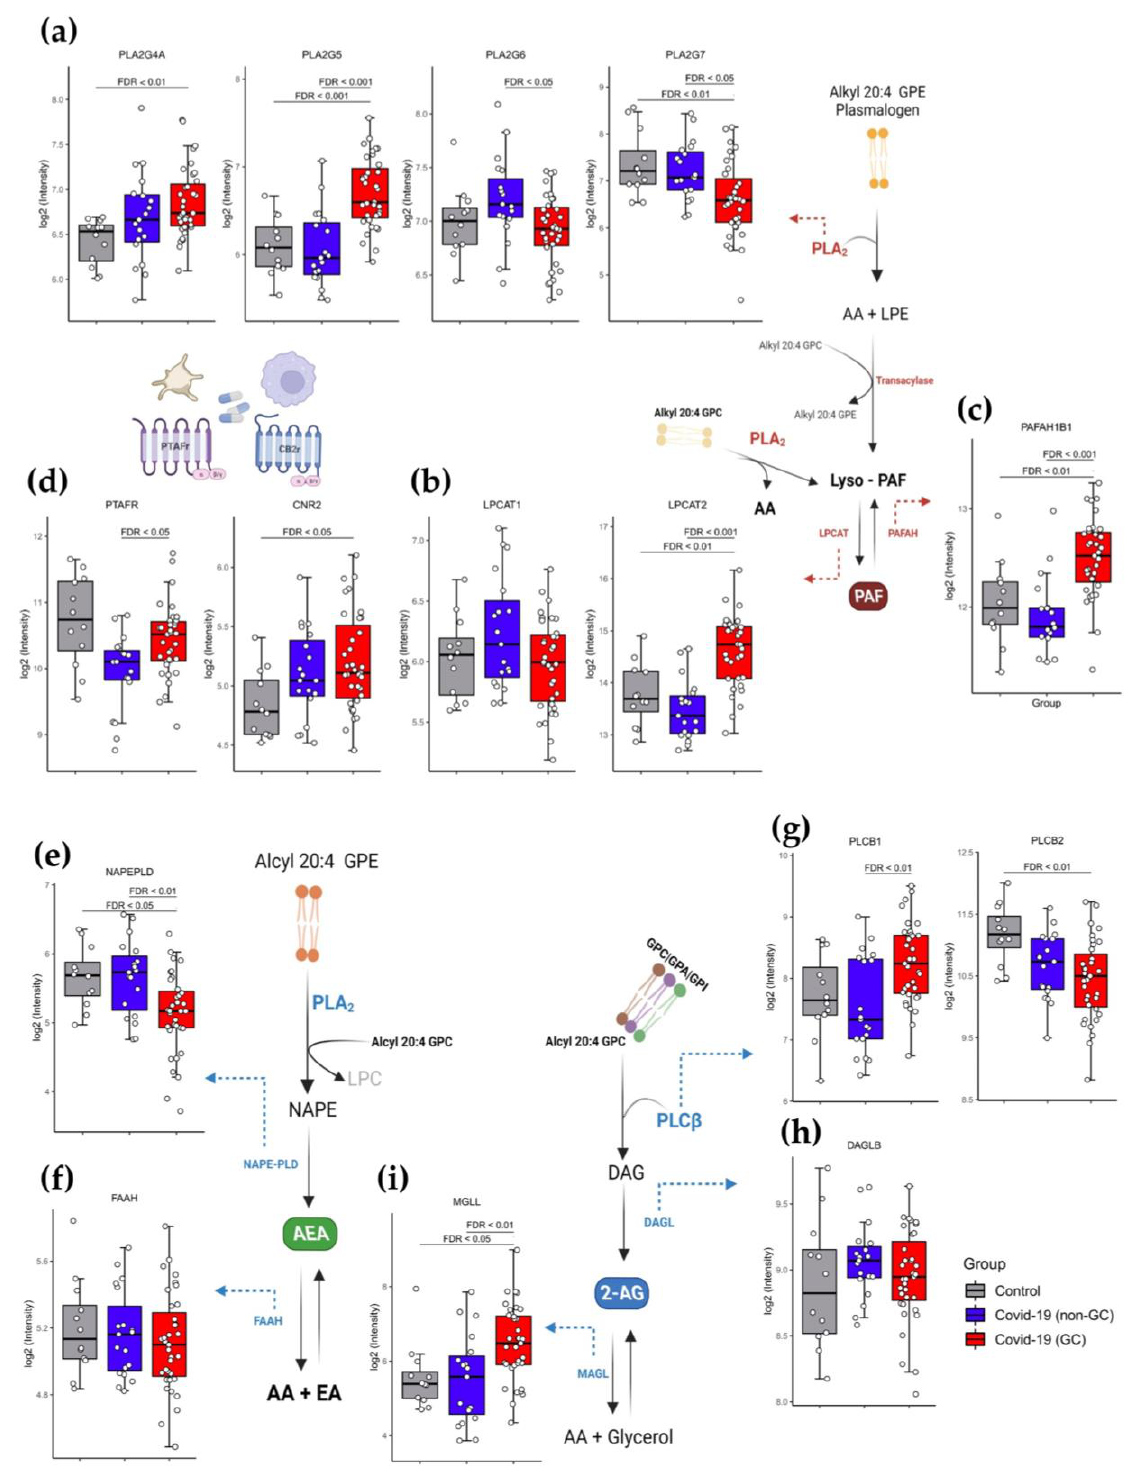
Figure 3. The influence of GCs in the gene expression of enzymes and receptors related to the eCB and PAF pathway in whole blood leukocyte transcriptomic data. Schematic representation of the PAF formation pathway, involved the genes: ( a ) PLA2G4A, PLA2G5, PL2G6 and PL2G7; ( b ) LPCAT1 and LPCAT2; ( c ) PAFAH1B1 and ( d ) PTAFR and CNR2. On behalf of eCB pathway for AEA formation,